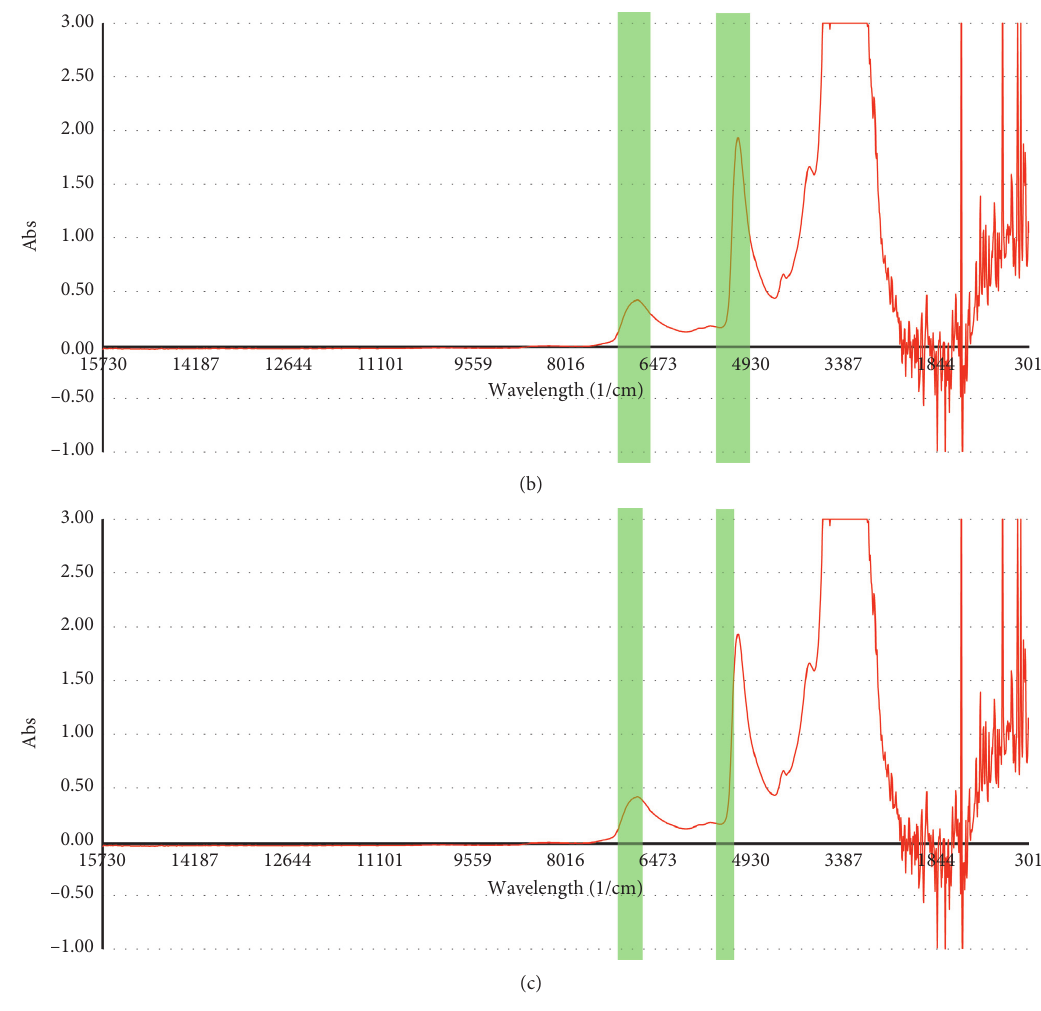
Figure 3: Selected region for (a) amine, (b) CO